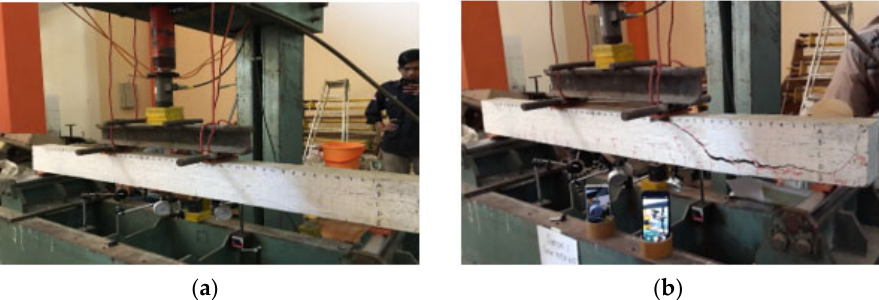
Figure 4. Testing the specimen beam ( a ) before and ( b ) after the beam shear failure.